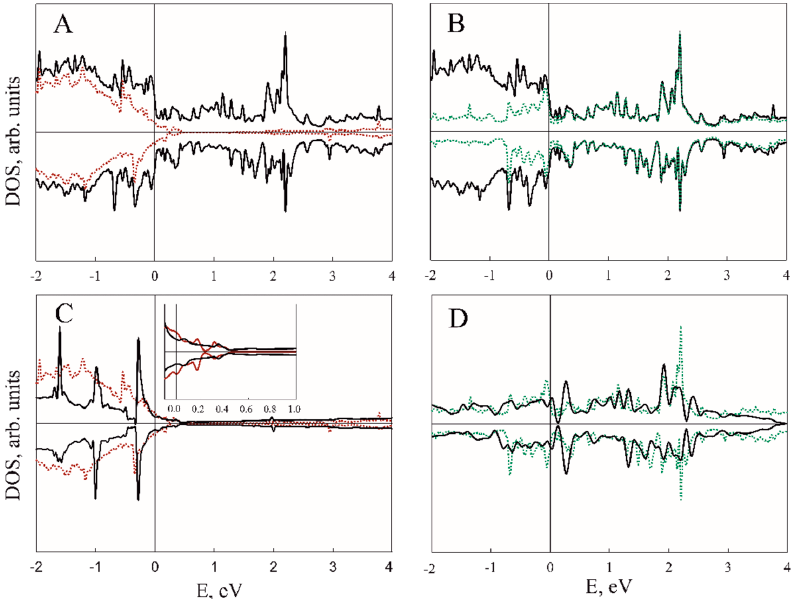
Figure 4. DOS for V 3 P 3 /ZnO composite. ( A ) Black and red lines correspond to composite TDOS and ZnO PDOS; ( B ) black and green lines correspond to composite TDOS and VP PDOS; ( С ) black and red lines correspond to TDOS of pristine ZnO slab and PDOS of ZnO fragment in V 3 P 3 /ZnO composite; ( D ) black and green lines correspond to TDOS of pristine V 3 P 3 slab and PDOS of VP in the composite structure, respectively.